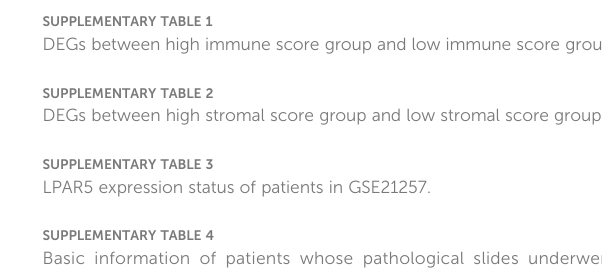
SUPPLEMENTARY TABLE 4 Basic information of patients whose pathological slides underwent immunochemical staining and immuno fl uorescence